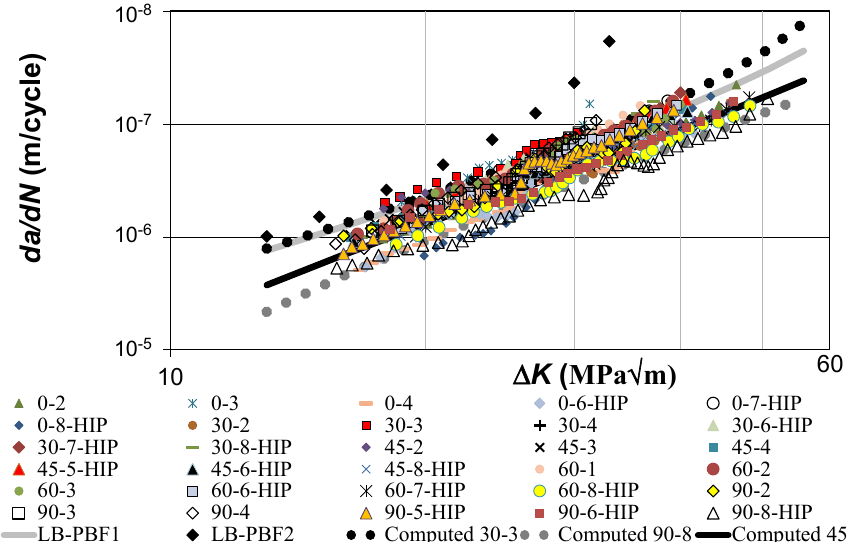
Figure 1. Variability in the thirty SLM Ti-6Al-4V tests reported in [9]. Table 1. Notation associated with the specimen tests reported in [9].